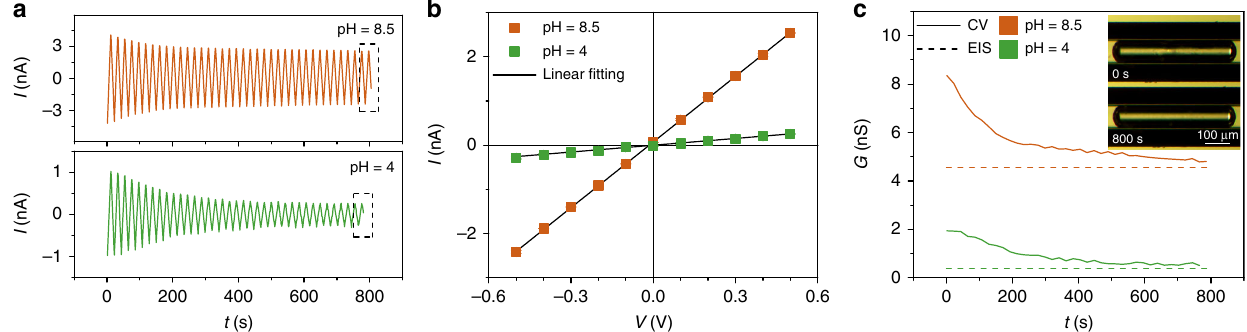
Fig. 2 The electrical characterization of the fi lm nanochannel. a The amplitude of fi lm nanochannel conductance measured by cyclic voltammetry decreased in time, becoming saturated after a certain number of cycles, at pH values of 8.5 (top) and 4 (bottom), respectively. b Typical I – V curves at the saturated states at pH values of 8.5 and 4 (dashed), showing the Ohmic behavior of the system. c The evolution of system conductance measured by CV (solid lines) gradually reached the value measured by EIS (dashed lines). Inset fi gure shows snapshot of a single bubble before (top) and after (bottom) the electrical measurements, exhibiting a smoother surface after the Fig. 2b. By linear fi tting the I – V curves (solid lines in Fig. 2b), we can derive the time evolution of the system conductance (Fig. 2c).